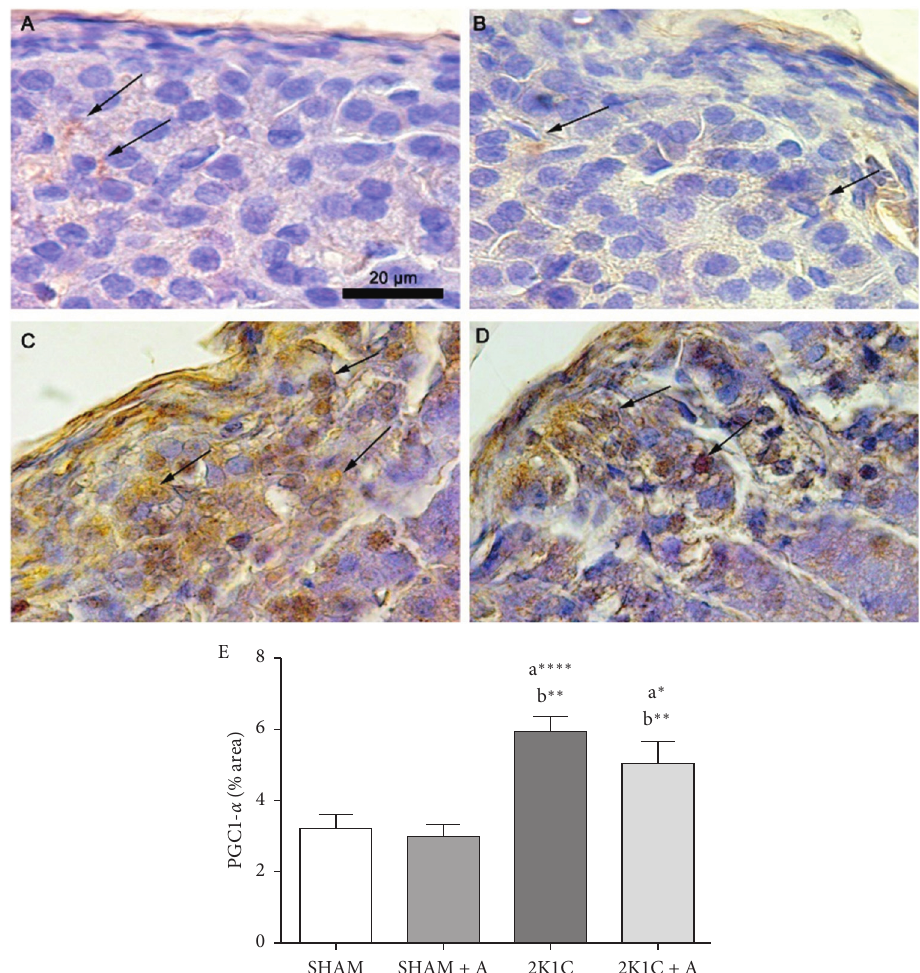
Figure 6: Detection of PGC1- α by immunostaining and quantification in the zona glomerulosa. Photomicrographs of groups (A) SHAM; (B) SHAM +A; (C) 2K1C; and (D) 2K1C +A. (E) Quantification of PGC1- α expression in the zona glomerulosa of all experimental groups. Arrows indicate the immunostained positive cells. (a) represents ≠ to the SHAM group, (b) represents ≠ to the SHAM +A group, and (c) represents ≠ to the 2K1C +A group. ∗∗∗∗ p < 0 . 0001, ∗∗ p < 0 . 01, and ∗ p < 0 . 05. n � 10 for all experimental